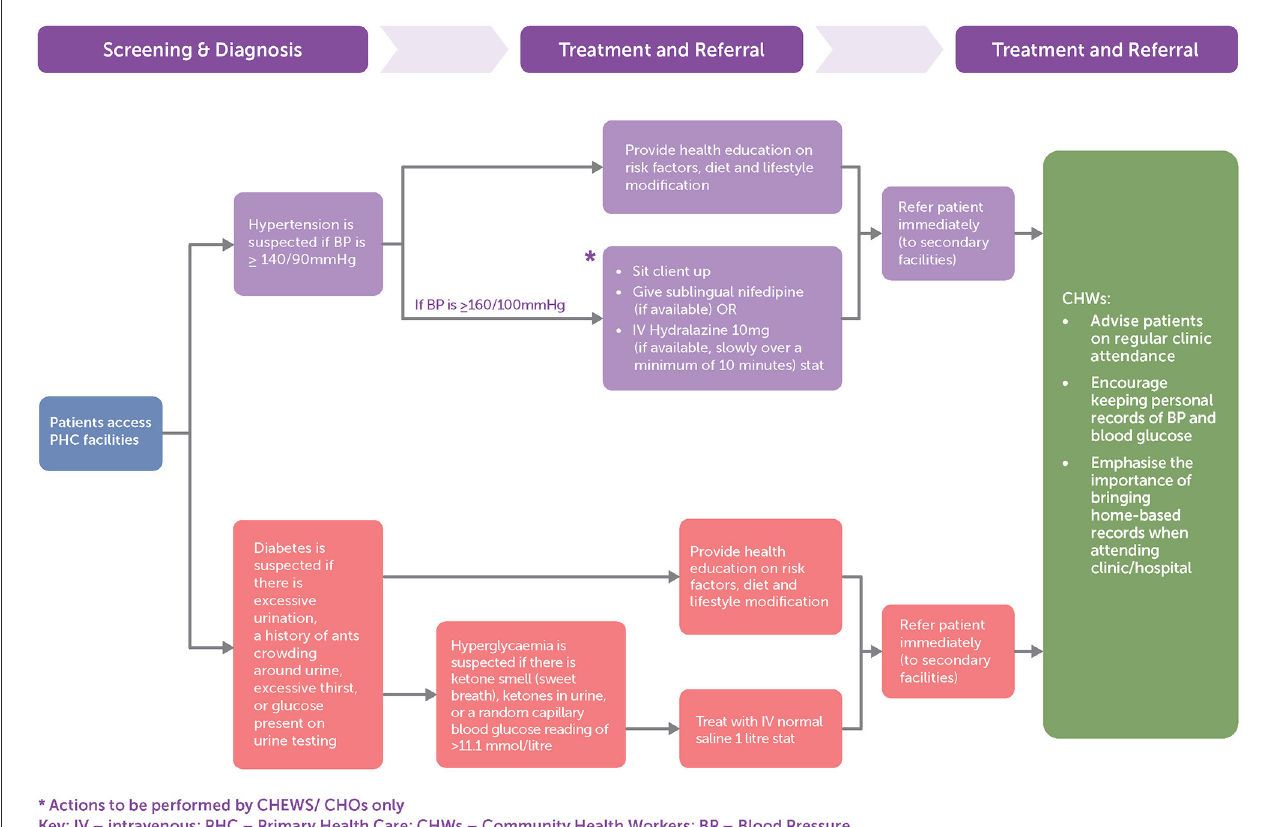
FIGURE1 Care of patients with hypertension and diabetes according to National Standing Orders for Junior Community Health Extension Workers (JCHEWs), Community Health Extension Workers (CHEWs), and Community Health Officers